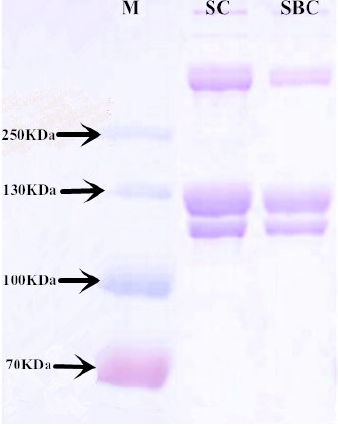
Figure 2. SDS-PAGE of collagen from C. idella skin (SC) and swim bladder (SBC). M: marker.